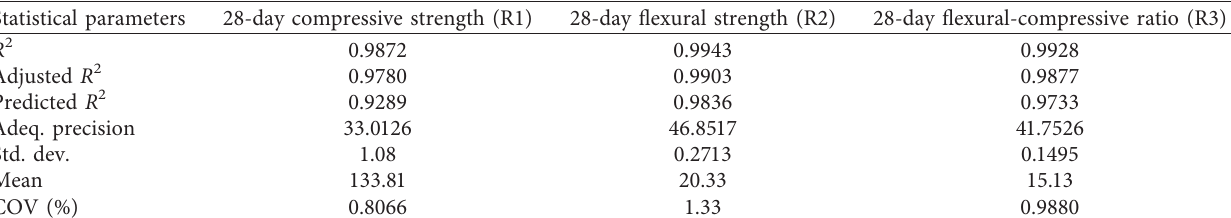
Table 13: Model validation for both